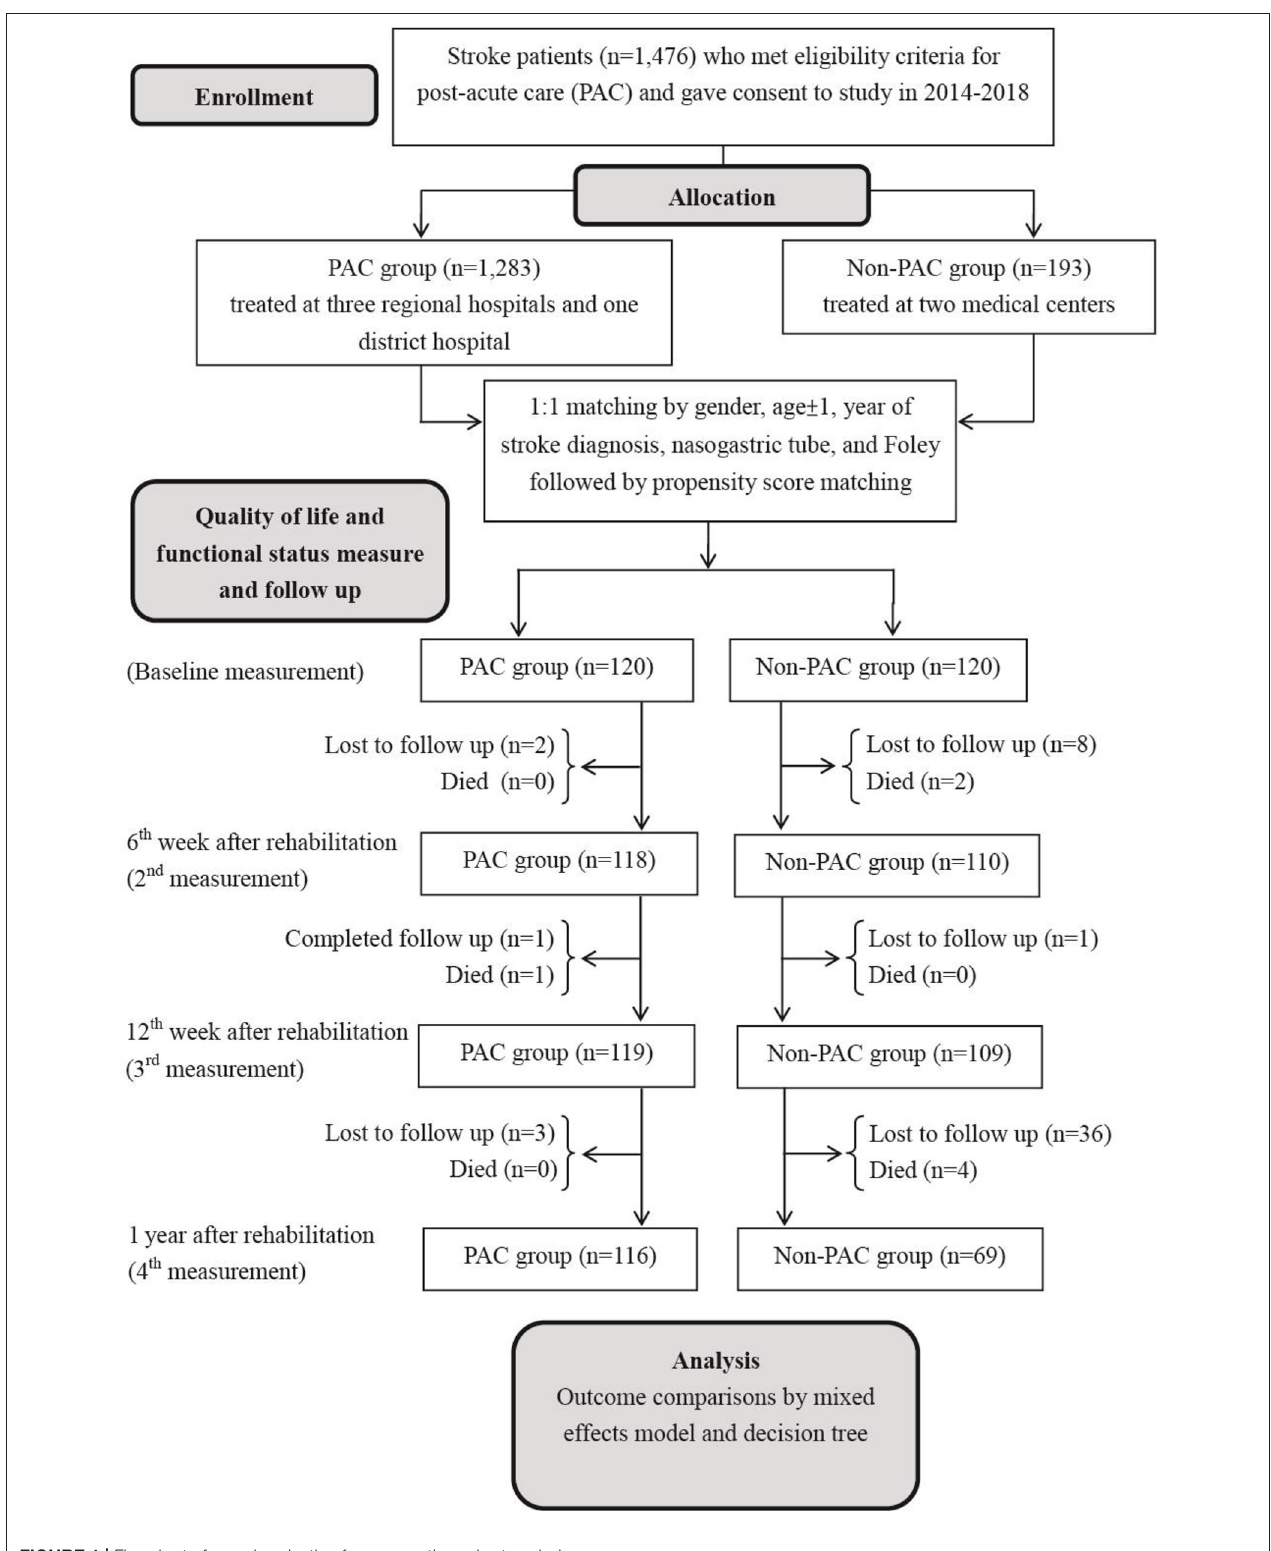
FIGURE 1 | Flowchart of sample selection for prospective cohort analysis.